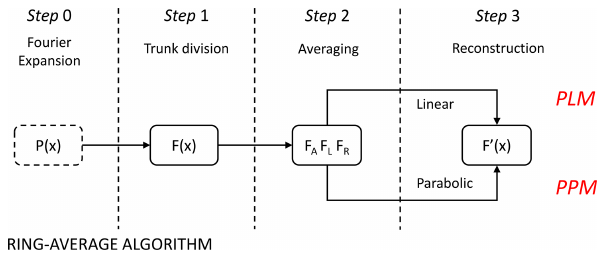
Figure 3. The ring average algorithm with both the PLM and